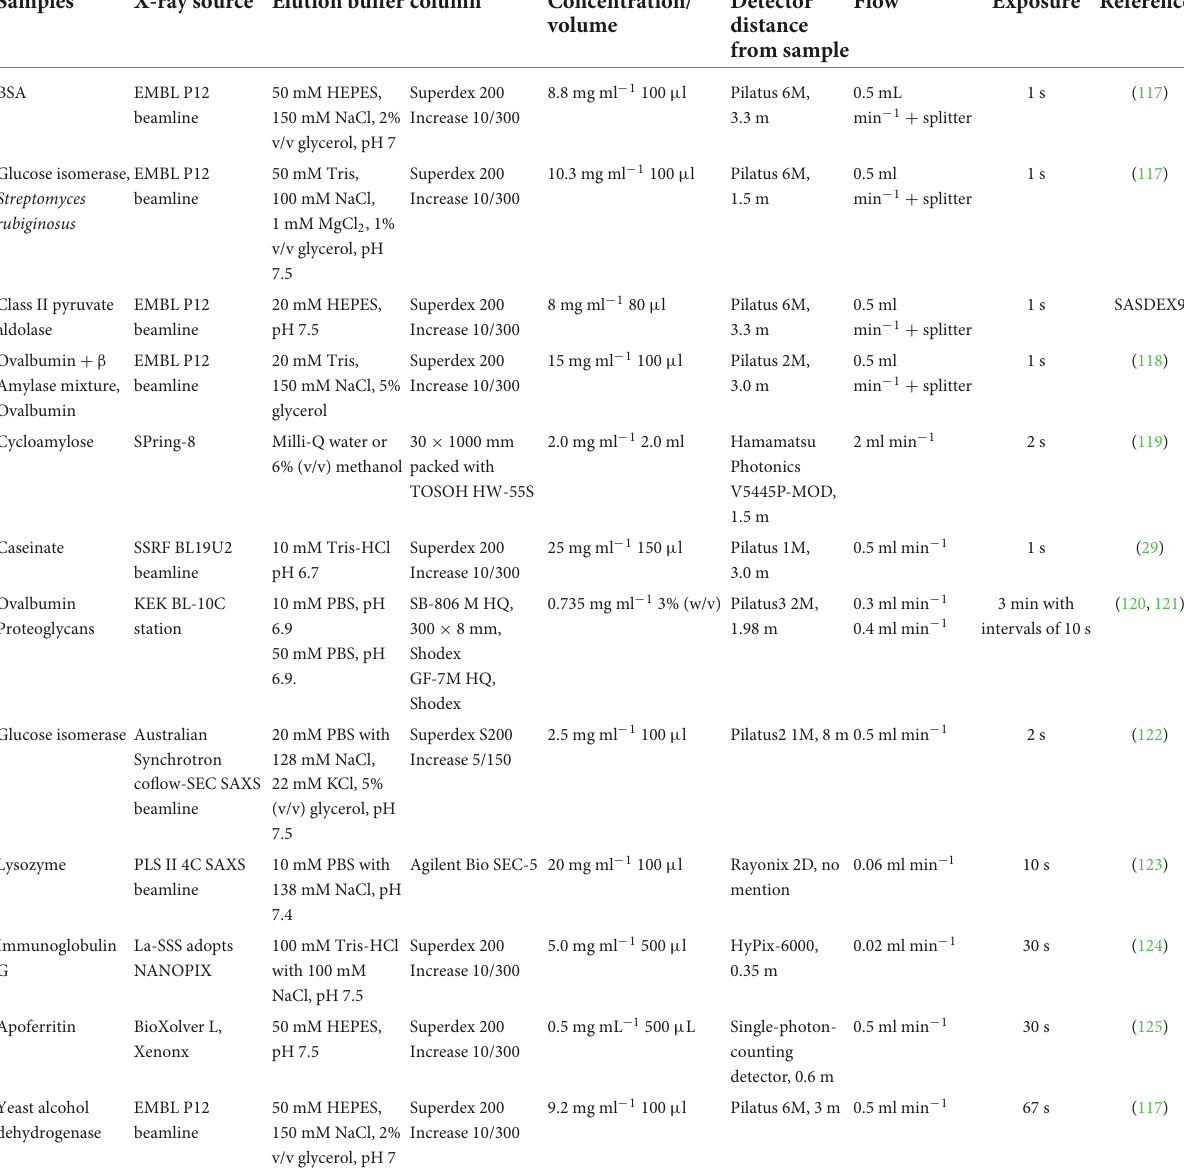
TABLE 2 Application of chromatography combined small-angle X-ray scattering (SAXS) for studying biomacromolecules.